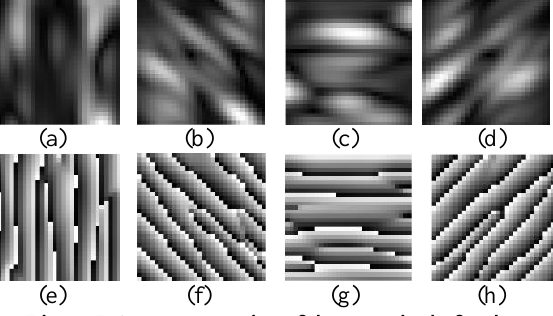
Figure 4. a) Face image b) A representation of the magnitude for the Gabor coefficient matrix c) A representation of the phase for the Gabor coefficient matrix.